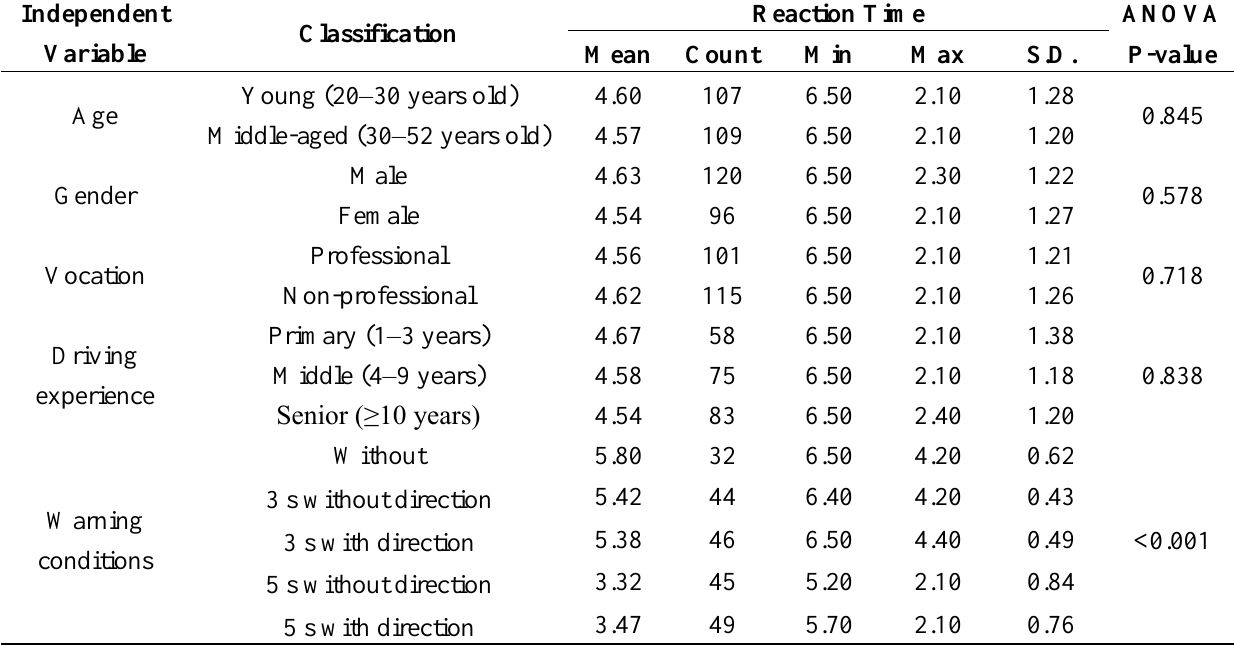
Table 6. The descriptive statistics of BRT and ANOVA